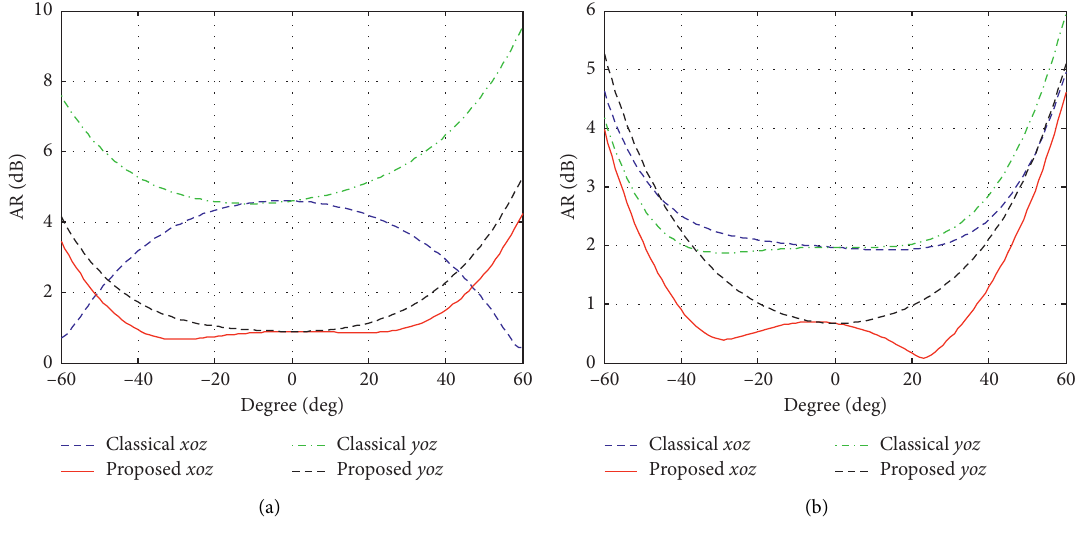
Figure 4: Simulated axial ratio. (a) 0.8GHz. (b) 1GHz.